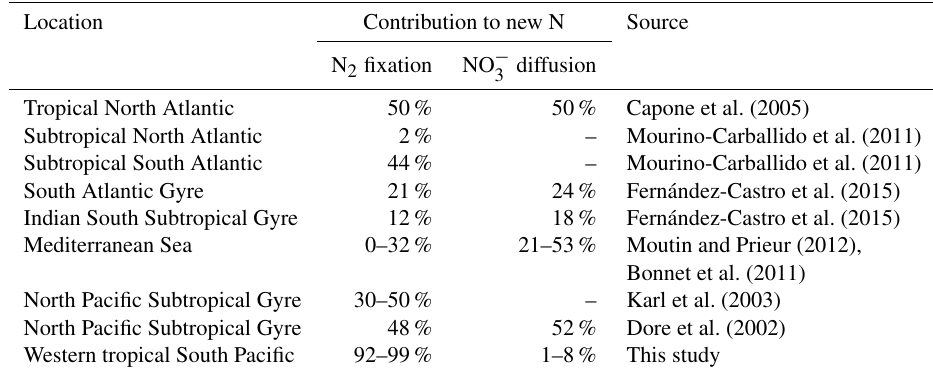
vertical diffusion to new N inputs in oligotrophic 3